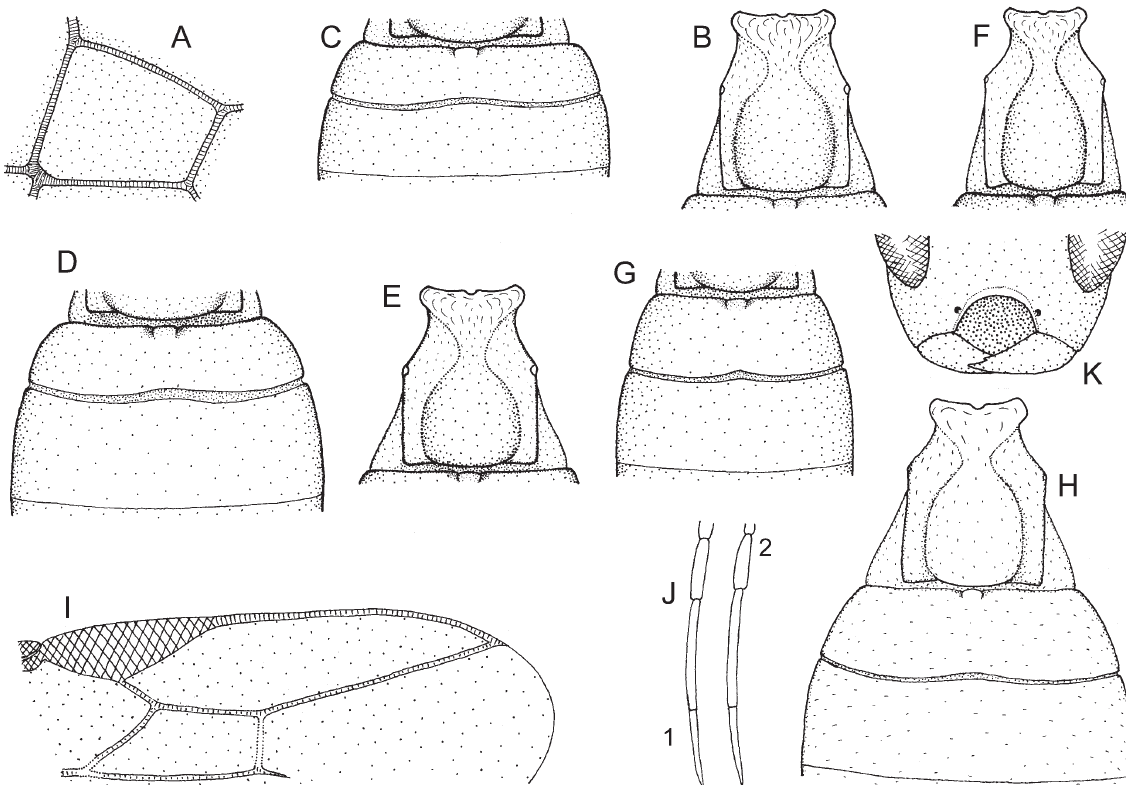
Fig. 55. — A-G . Bracon ( Palpibracon ) delibator Haliday, 1833 (A-D: ♀, E-G: ♂). A . First discal cell of right forewing. B . First tergite. C-D . Tergites 2-3. E-F . First tergite. G . Tergites 2-3. — H-K . Bracon ( Palpibracon ) atrator Nees, 1834, ♀ neotype. H . Tergites 1-3. I . Distal part of right forewing. J . Ultimate three segments of maxillar palp (1 = neotype, 2 = ♀ / ♂), K . Head in frontal